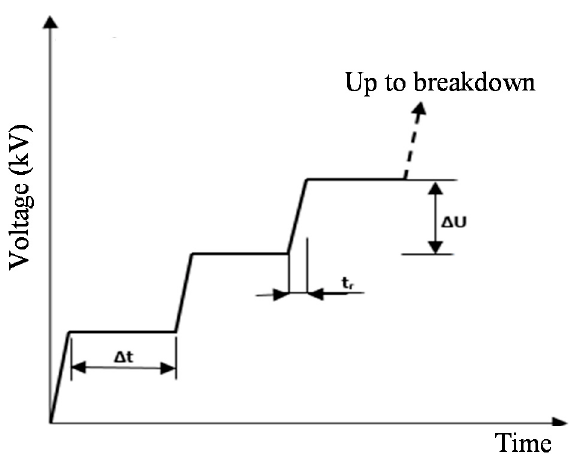
Figure 1. DC test procedure.